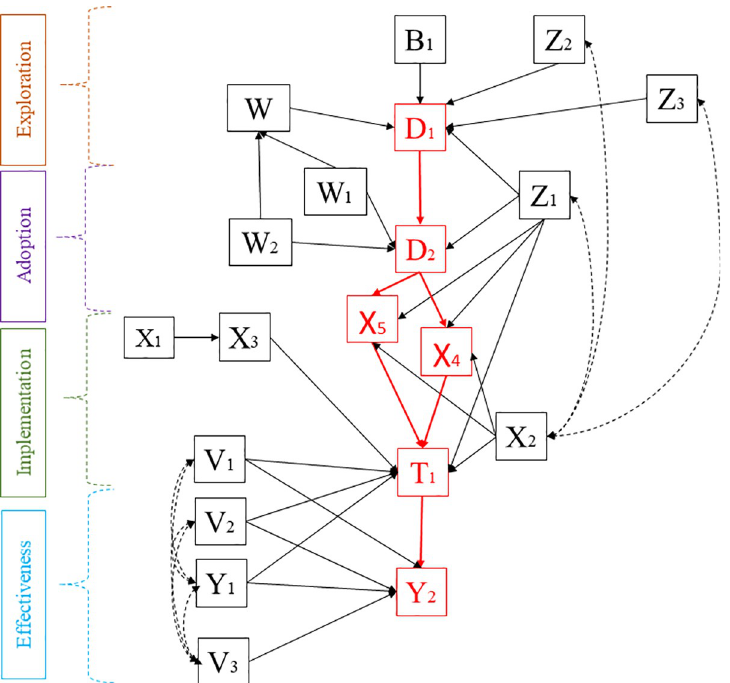
Fig 4. Directed acyclic graph for a hypothetical implementation of